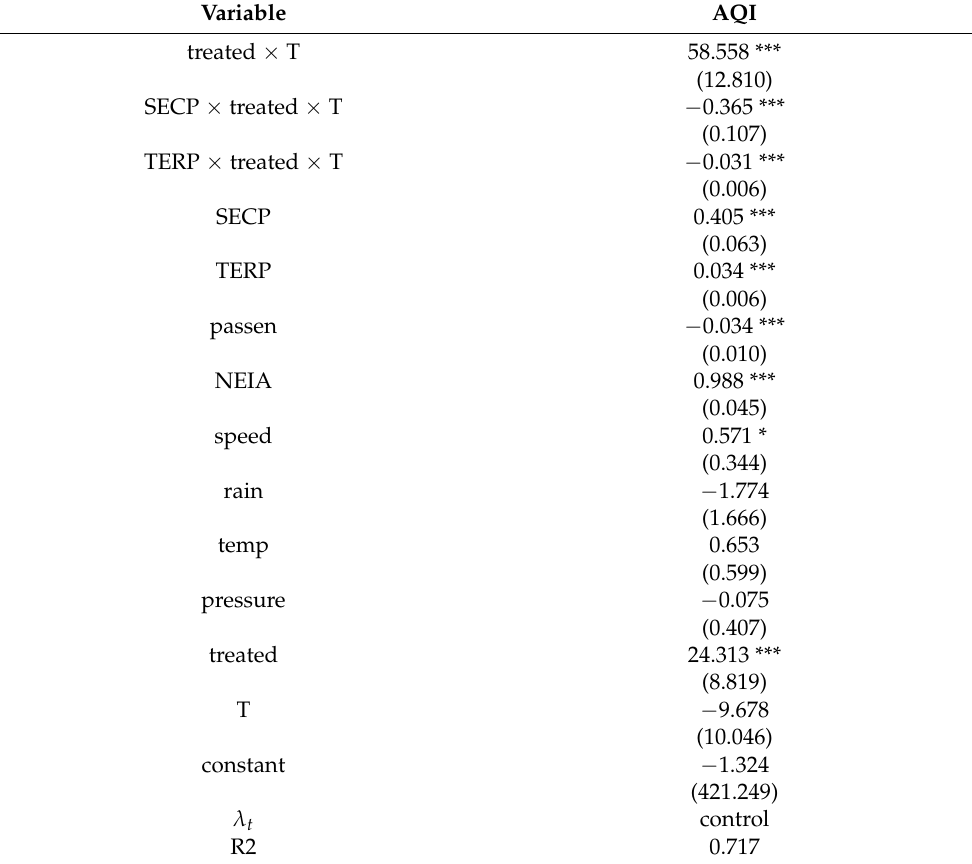
Table 5. DID regression results of industrial adjustment on